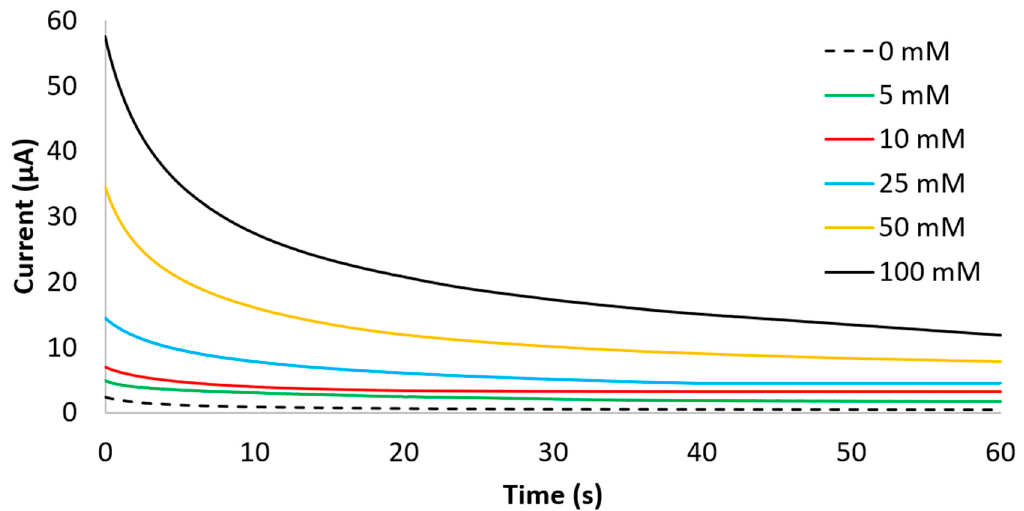
Figure 9. Chronoamperograms at +500 mV recorded at different glucose concentration.